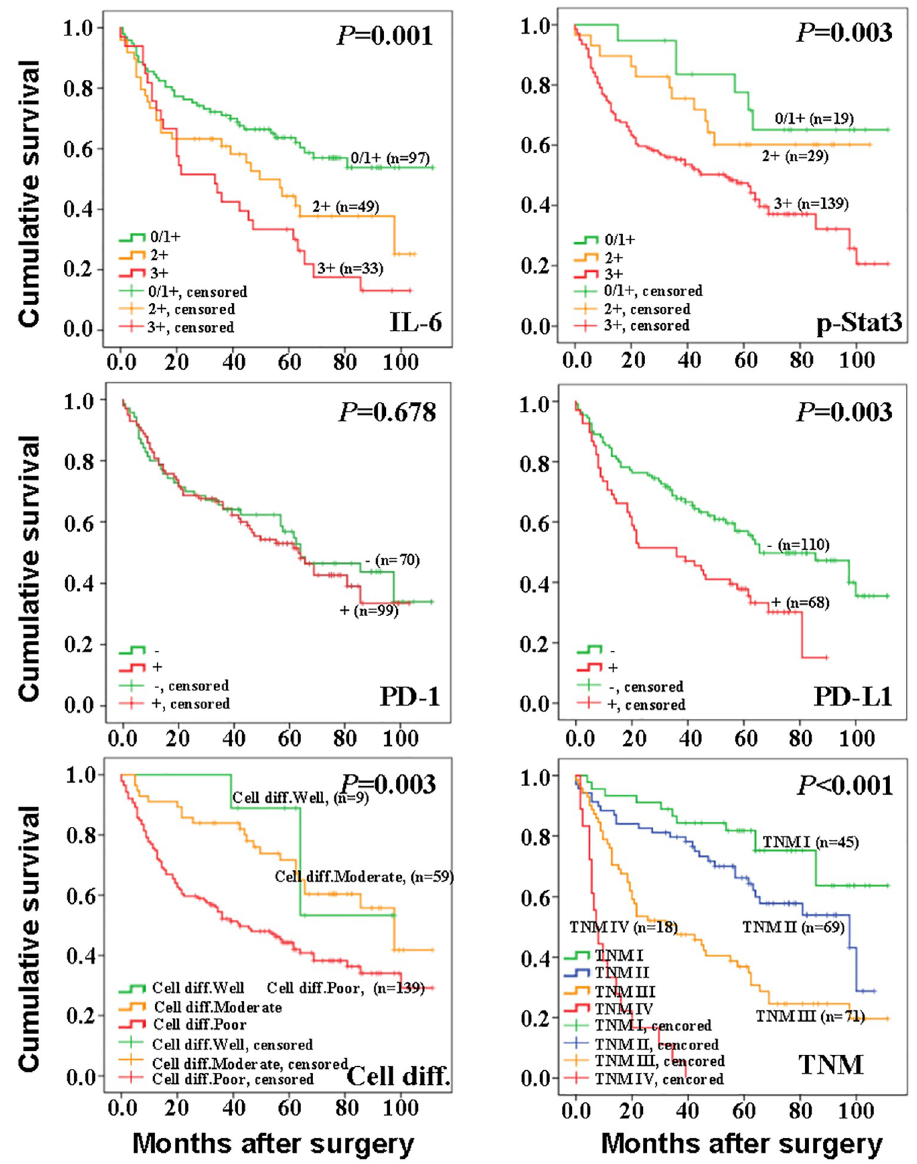
Fig 2. Effects of TNM stage, differentiation degree, IL-6, p-Stat3, PD-1 and PD-L1 on survival of gastric cancer patients. Impacts of TNM staging, cell differentiation, IL-6, p-Stat3, PD-1 and PD-L1 on the survival of GC patients. Comparisons of Kaplan-Meier survival curves for GC patients categorized as the following: 0/1+ vs. 2+ vs. 3+ of IL-6 (P = 0.001), p-Stat3 (P = 0.003),—vs. + of PD-1 (P = 0.678), PD- L1 (P = 0.003), respectively; clinical staging of TNM I vs. TNM II vs. TNM III vs. TNMIV (p < 0.001); cell differentiations of well vs. moderate vs. poor (P =